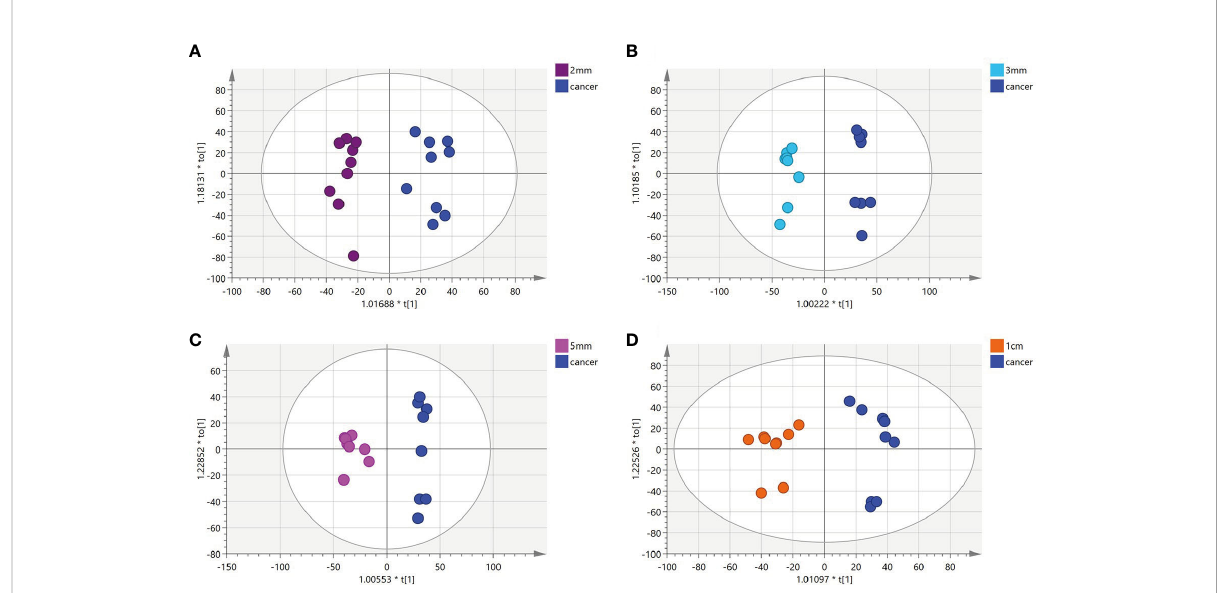
FIGURE 2 (A-D) Orthogonal partial least squares discriminant analysis (OPLS-DA) score plots comparing between tissue located at other surgical margins and cancer